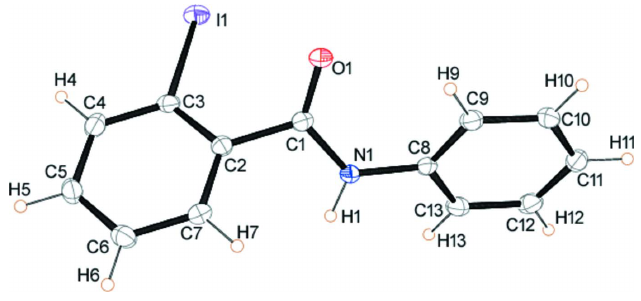
Figure 2 The molecular structure of (II) showing the atom numbering with ellipsoids drawn at the 50% probability level.